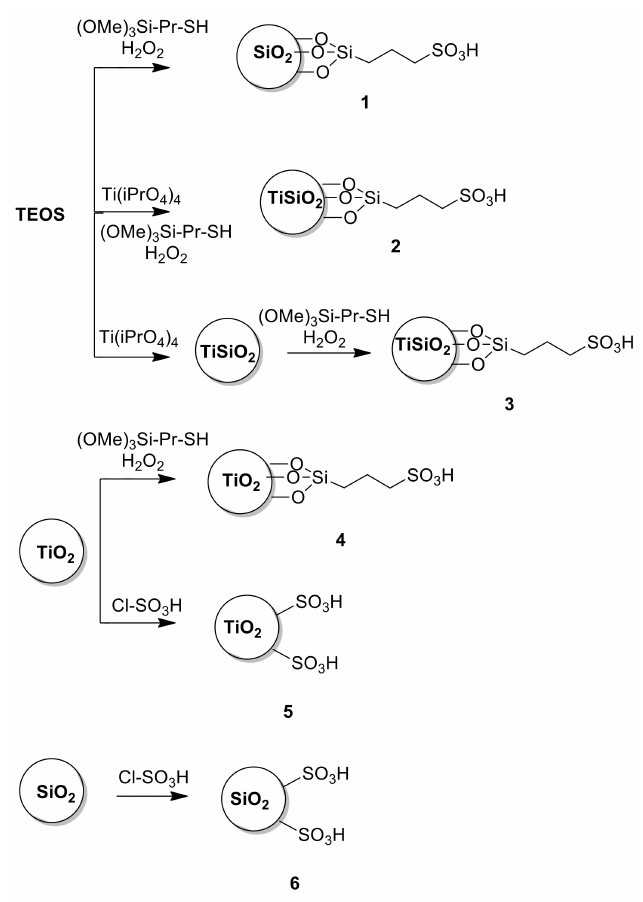
Figure 2. Chemical procedures for the synthesis of sulfonic